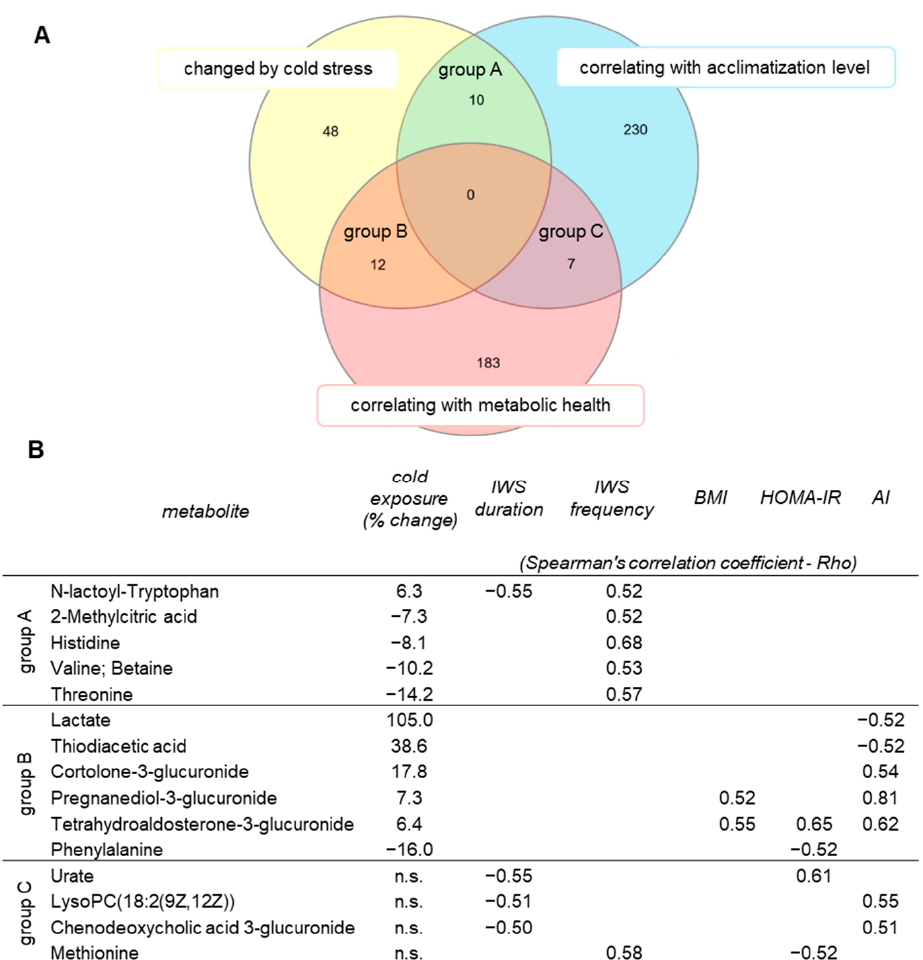
Figure 5. Identification of plasma metabolites changed by acute cold exposure and related to acclimatization level (IWS/ice-water swimming habit duration and/or frequency) and/or to metabolic health (BMI/body mass index, HOMA-IR/Homeostatic Model Assessment for Insulin Resistance, AI/atherogenic index), ( A ) presented in Venn diagram and ( B ) filtered to only those metabolites that are detected in humans according to The Human Metabolome Database. Acute cold-induced changes in levels of plasma metabolites were used in the associations, analyzed using Spearman’s correlation, shown are those with Spearman’s correlation coefficient (Rho) < − 0.5 or > 0.5. All metabolites changed by cold exposure had p < 0.05 after Benjamini–Hochberg correction. n.s., not significant.